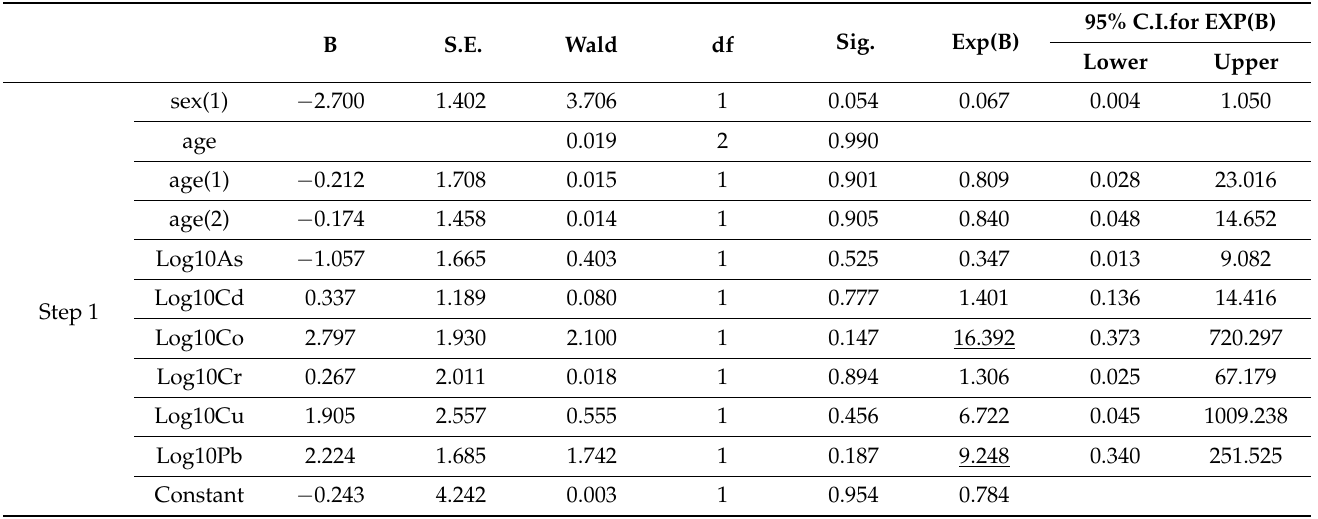
Table A3. Variables in the equations (Exp(B) values of Pb and Co